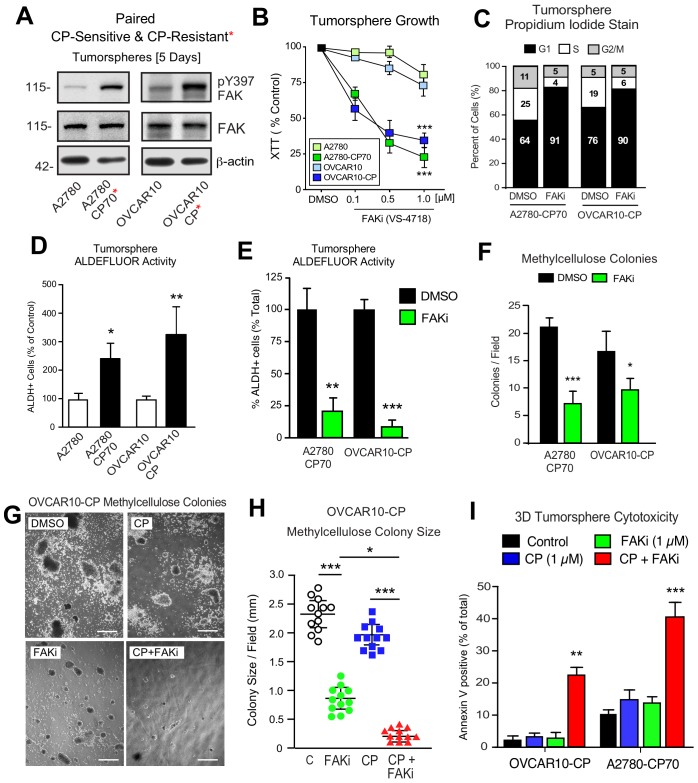
Acquired FAK dependence for CP-resistant tumorsphere growth.(A) Human A2780, A2780-CP70, OVCAR10, and OVCAR10-CP tumorsphere lysates immunoblotted for FAK pY397, total FAK, and actin. (B) Growth of A2780, OVCAR10, A2780-CP70, or OVCAR10-CP cells as tumorspheres in the presence of FAKi (VS-4718, 0.1 to 1.0 µM) for 4 days. Values are means (± SEM, ***p<0.001, one-way ANOVA) from two independent experiments. (C) A2780-CP70 or OVCAR10-CP cells grown as tumorspheres (3 days) were treated with DMSO or FAKi (VS-4718, 1 µM) for 24 hr, stained with propidium iodide, and analyzed by flow cytometry. Shown is percent of cells in G0/G1, S, or G2/M phase of the cell cycle. (D) Quantitation of A2780-CP70 and OVCAR10-CP colony formation in methylcellulose (21 days) with DMSO (control) or FAKi (VS-4718, 1 µM). Values are means (± SEM, *p<0.05, ***p<0.001, unpaired T-test) from two independent experiments. (E) A2780-CP70 and OVCAR10-CP tumorsphere ALDEFLUOR activity treated with DMSO or FAKi (VS-4718, 1 µM) for 24 hr. Values are means (± SEM, **p<0.01, ***p<0.001, one-way ANOVA compared to DMSO) for three independent experiments. (F) Quantitation of A2780-CP70 and OVCAR10-CP methylcellulose colony formation (21 days). Values are means (± SEM, *p<0.05, ***p<0.001, unpaired T-test) from two independent experiments. (G and H) Representative OVCAR10-CP methylcellulose colony formation (21 days) (panel G) and colony size (panel H) in the presence of DMSO (control), CP (1 µM), FAKi (1 µM), or CP plus FAKi. Scale is 2.5 mm. Values are means (± SEM, *p<0.05, ***p<0.001, one-way ANOVA) from two independent experiments. (I) A2780-CP70 and OVCAR10-CP tumorsphere cytotoxicity (annexin V) in the presence of DMSO (control), CP (1 µM), FAKi (1 µM), or CP plus FAKi. Values are means (± SEM, **p<0.01, one-way ANOVA) from three independent experiments.